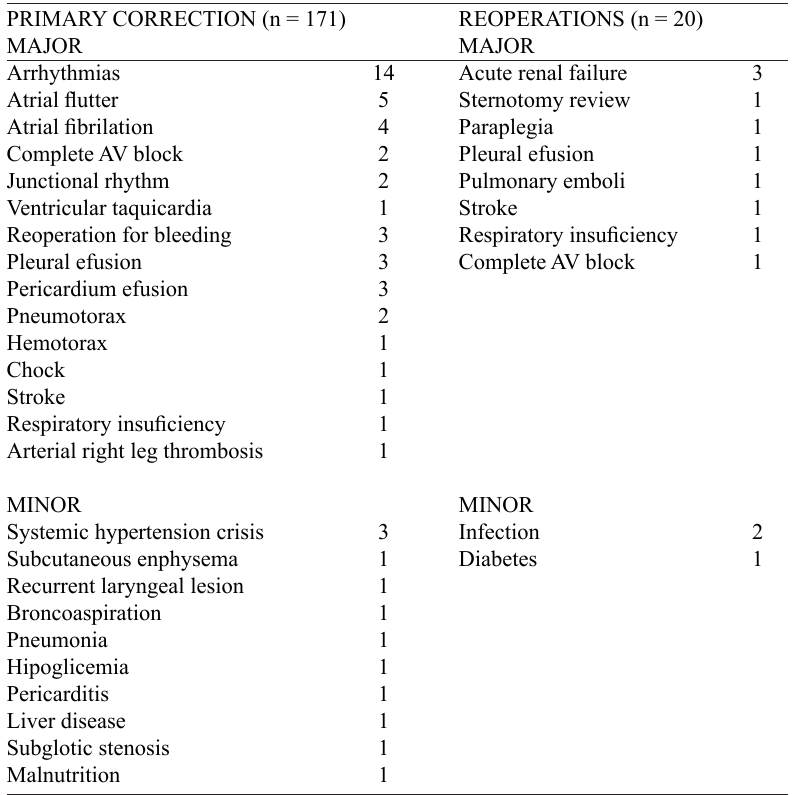
Table 2. Immediate postoperative complications in 191 adult patients operated on for treatment of congenital heart